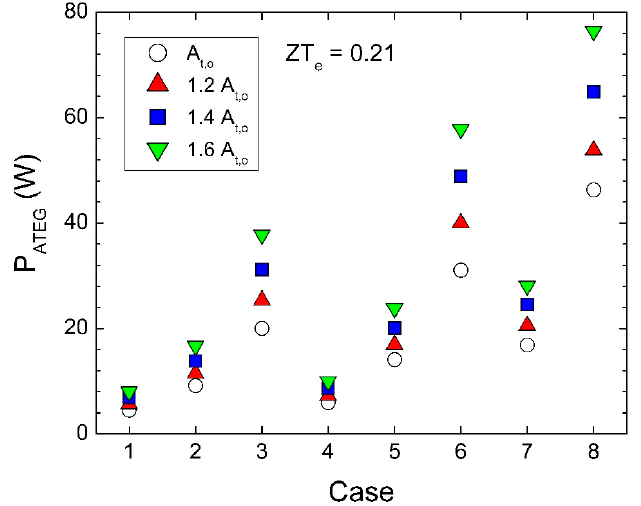
Figure 11 . Electrical output power for the cases shown in Figure 3 when using heat absorbers with different total surface area A t . Numerical results.